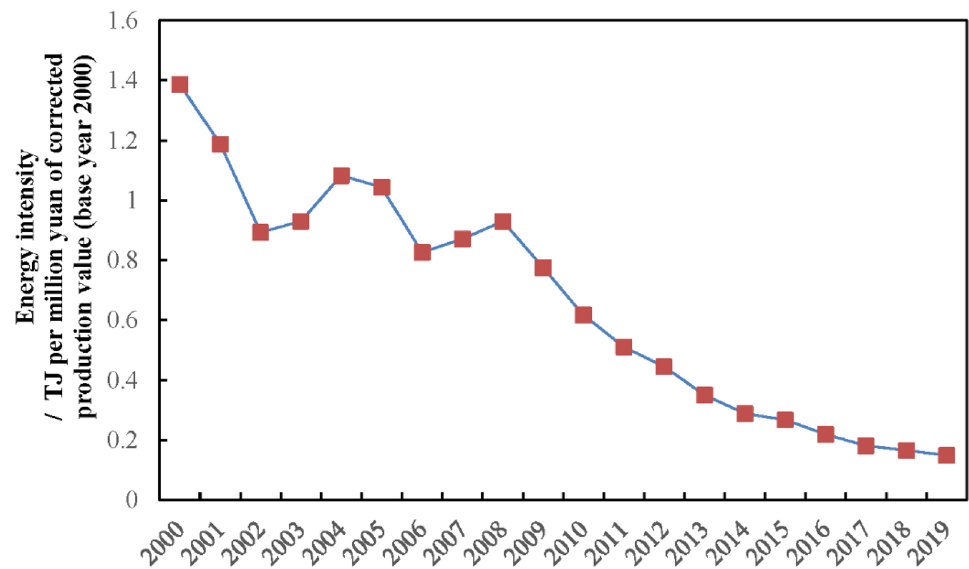
Fig. 3 Energy intensity of the wood and bamboo processing industry in China from 2000 to